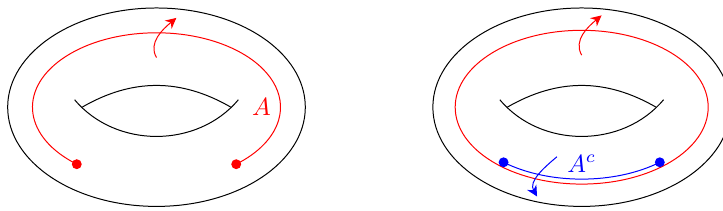
Figure 3 . Branch cut structure for large intervals. We can decompose the branch cut along A (denoted in red on the left) into a branch cut along the full spatial circle (denoted in red on the right) and a branch cut in the opposite direction along A c (denoted in blue on the